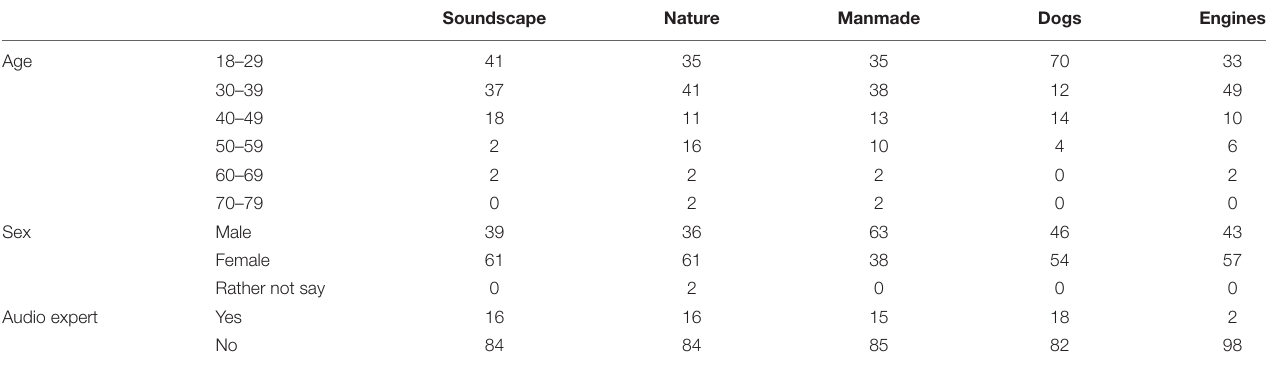
TABLE 1 | Demographic data of participants for all